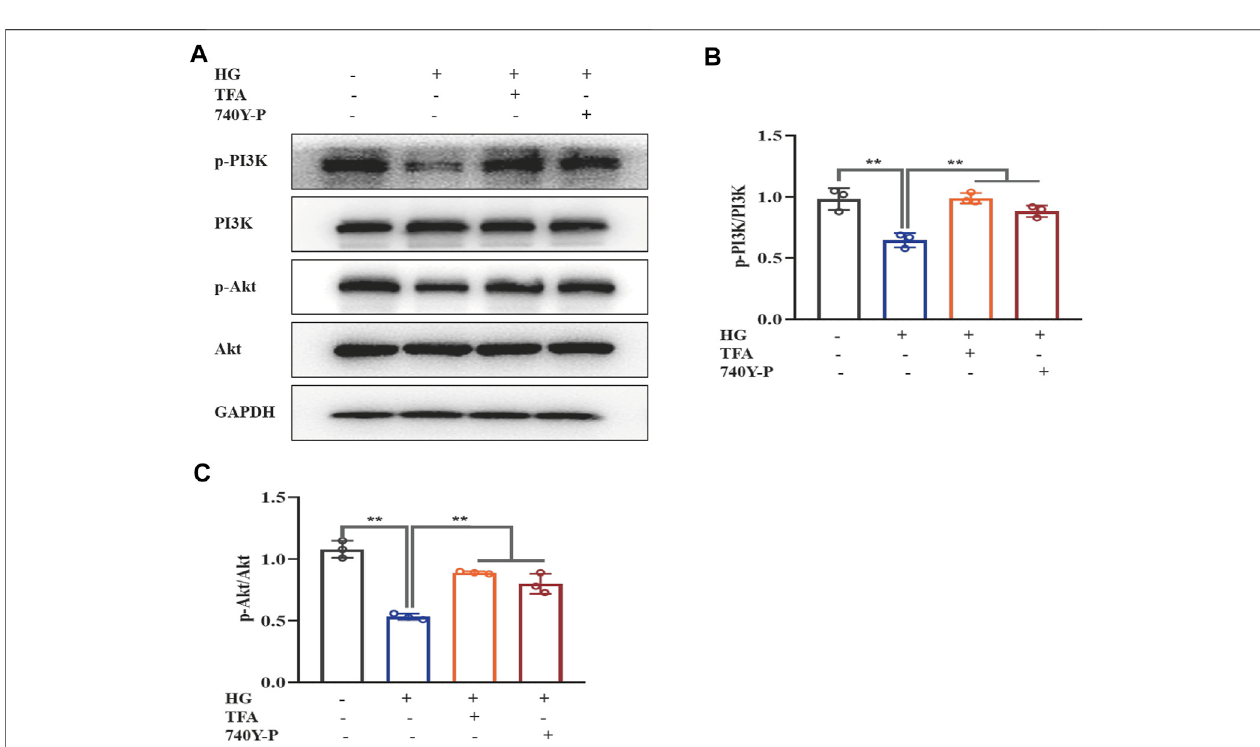
FIGURE 6 | TFA and 740Y-P activated the PI3K/Akt signaling pathway in HG-af fl icted MPC-5 cells. (A) WB analysis of p-PI3K, PI3K, p-Akt, and Akt, in cultured MPC-5 cells exposed to HG at 30 mM for 48 h with or without TFA (20 μ g/ml) and 740Y-P (30 μ M) treatment for 24 h; (B) p-PI3K was quanti fi ed by densitometry; (C) p-Akt was quanti fi ed by densitometry. Data are expressed as mean ± S.D., ( n (cid:2) 3). * p < 0.05, ** p < 0.01. Abbreviations: TFA, total fl avones of Abelmoschus manihot ; PI3K, phosphatidylinositol 3-kinases; Akt, protein kinase B; HG, high glucose; MPC-5, mouse podocyte cell-5; WB, western blotting; p-PI3K, phosphorylated- phosphatidylinositol 3-kinase; p-Akt, phosphorylated-protein kinase B.